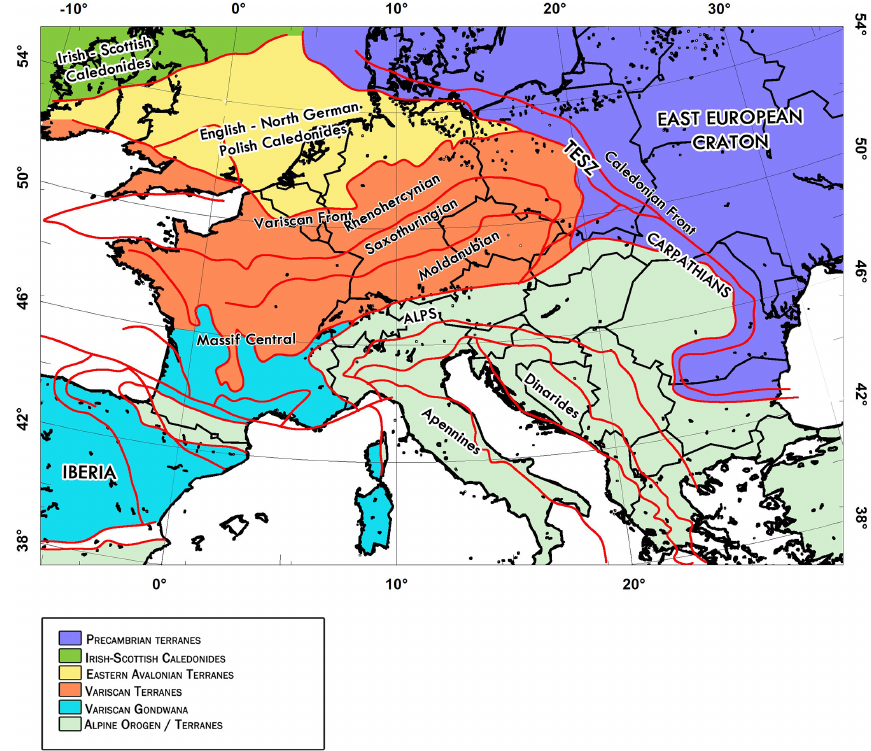
Figure 2. Tectonic setting of the European continent (redrawn after Blundell et al., 1992; Plant et al.,